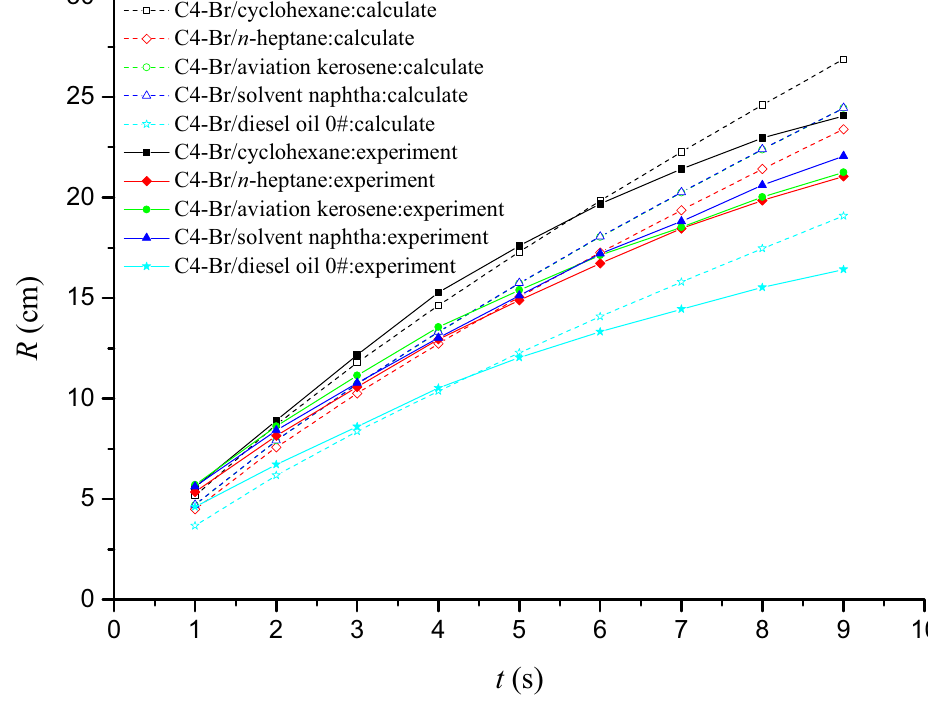
Figure 5. The R - t graphs of C4-Br/oil systems obtained from experiment and theoretical calculate.